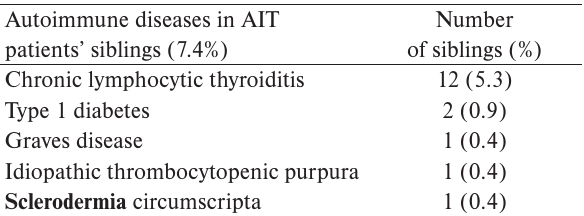
Table 2. Frequencies of autoimmune diseases in AIT patient’s